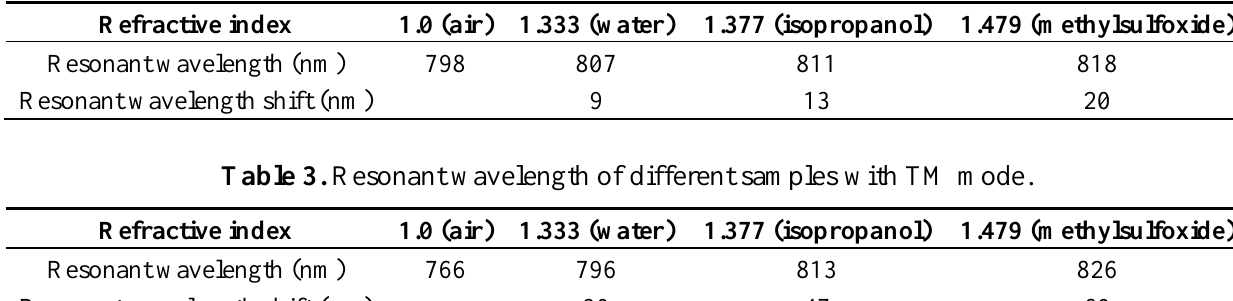
Table 2. Resonant wavelength of different samples with TE mode.